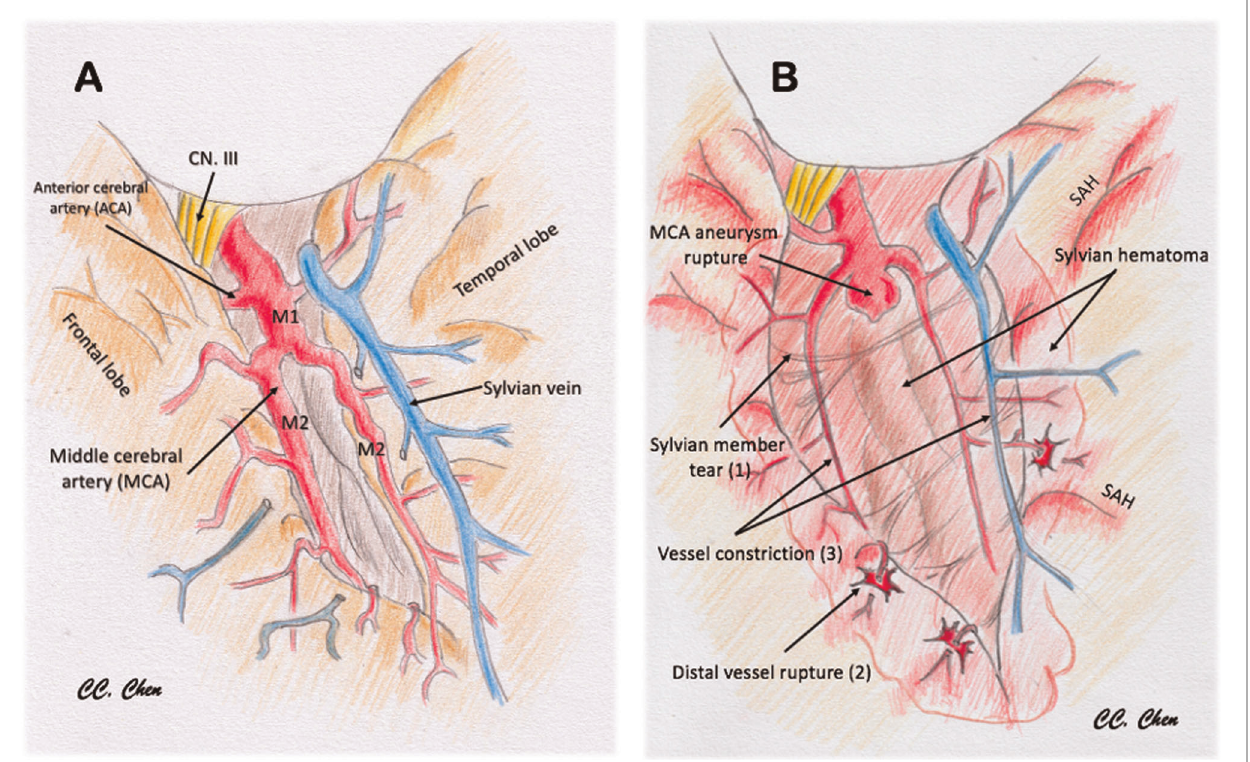
FIGURE 2 | Illustration to demonstrate the pathomechanism of delayed progressive mass effect. ( A ) Normal vessels and sylvian fi ssure. ( B ) Pathological change after MCA aneurysm rupture with sylvian hematoma: (1) sylvian member and pia tear by the stretch of hematoma; (2) cortical artery was straightened and distal vessel rupture (spots sign or distal hematoma); (3) vessel diameter lessening, fl ow obstruction, and ischemia by hematoma compression (perisylvian low